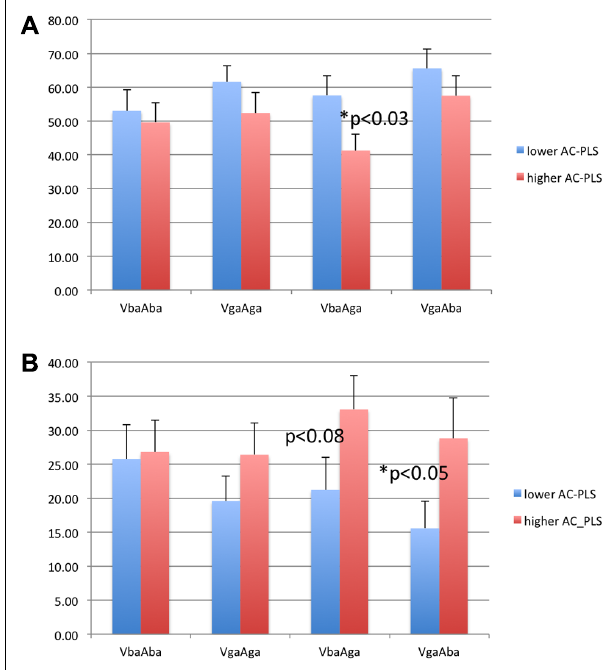
FIGURE 4 | Looking time to the mouth (A) and eyes (B) as percentage of looking time to the face in 6–9 month-old infants with higher and lowerAC-PLS scores at the follow-up